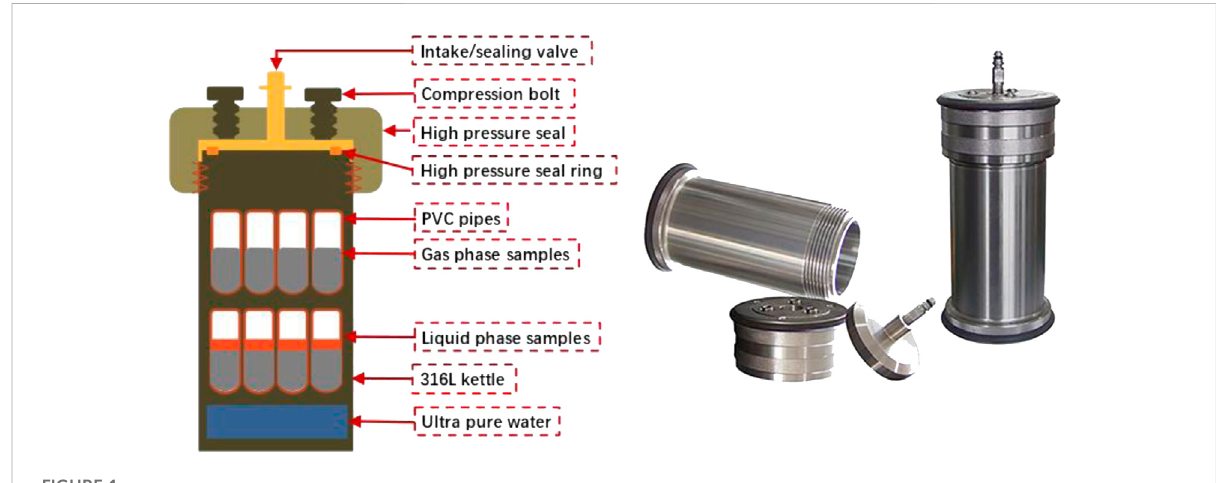
FIGURE 1 Photograph and schematic representation of HTHP carbonation kettle and sample loading.